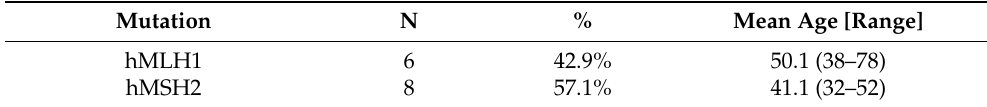
Table 6. Frequency of MMR gene mutation in LS-related